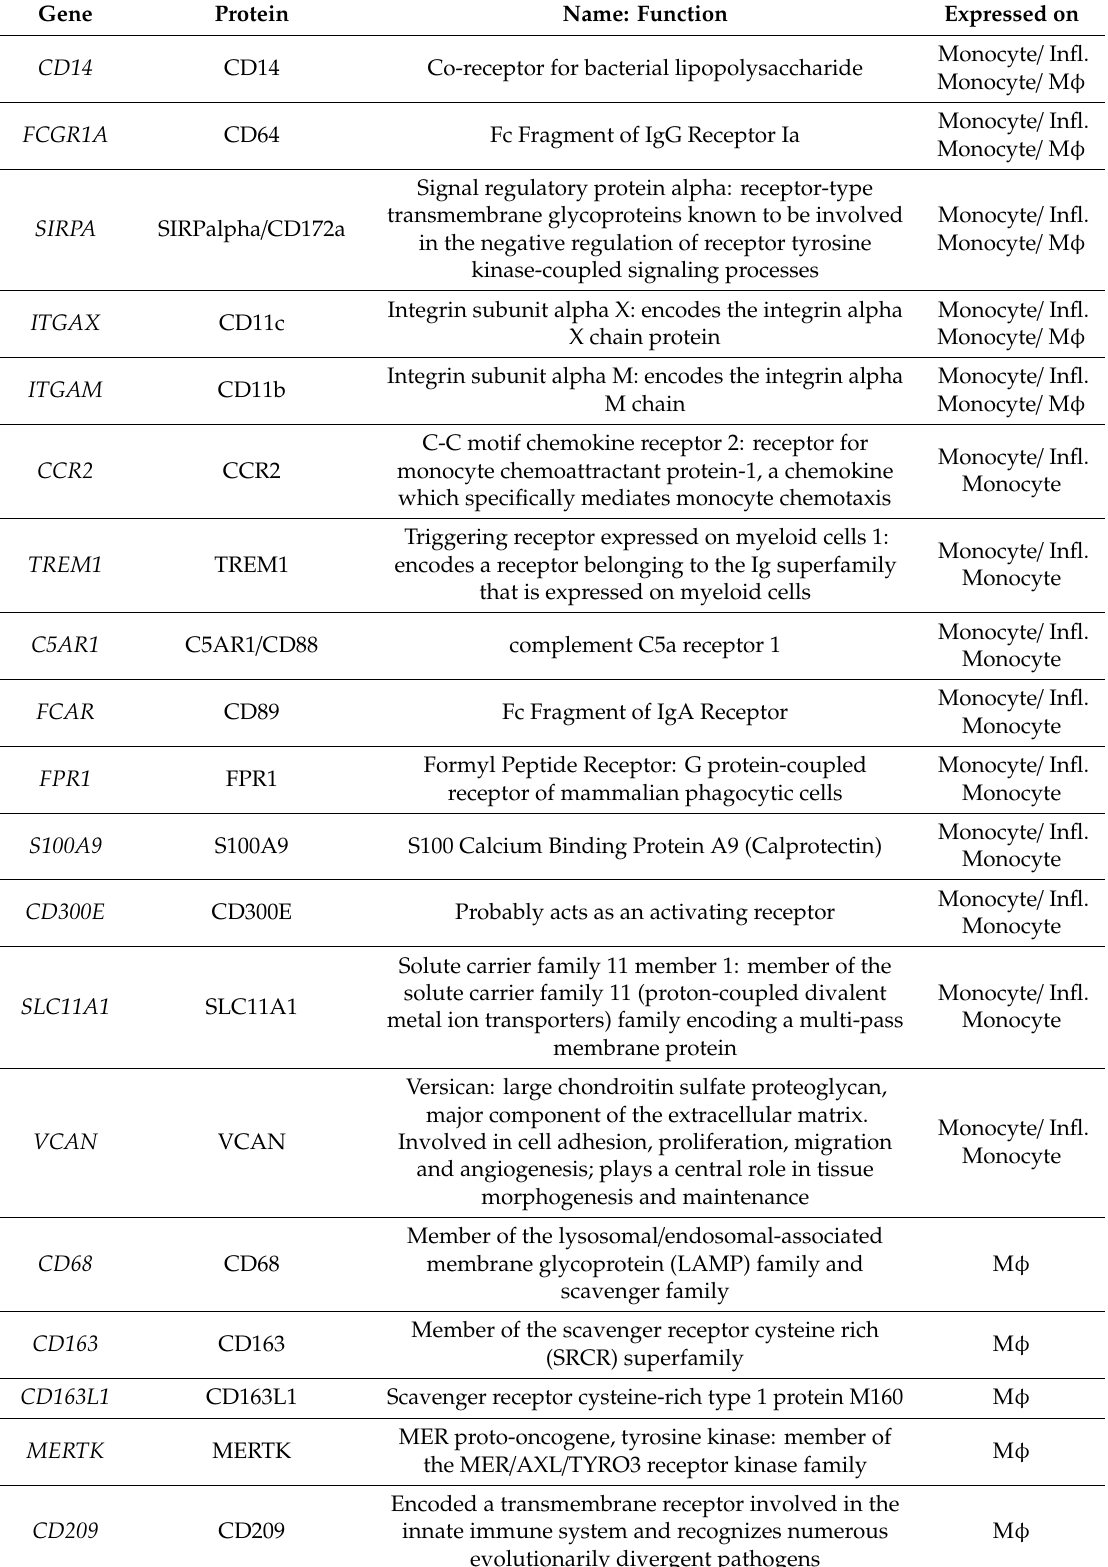
Table 1. Gene and protein expression on intestinal monocytes, inflammatory monocyte-like and macrophages (function as referenced at https: // www.ncbi.nlm.nih.gov /